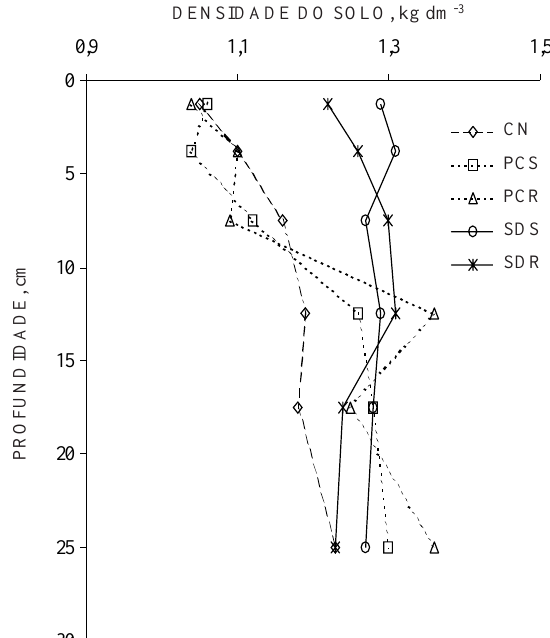
Figura 1. Densidade do solo em